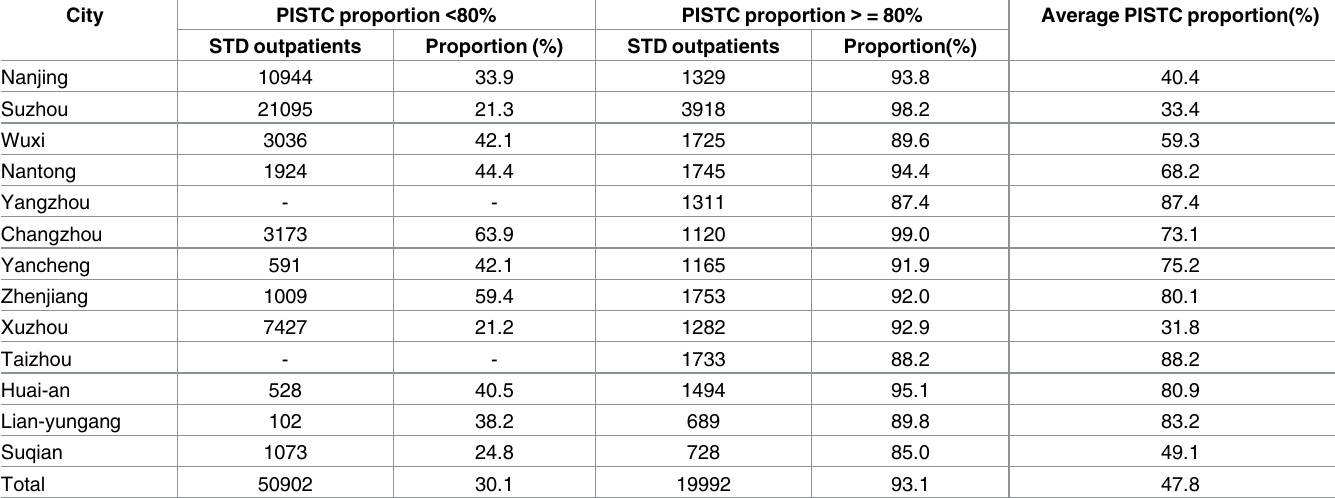
Table 2. The PISTC among 70894 patients in 250 medical institutions with STD clinic in Jiangsu, China,